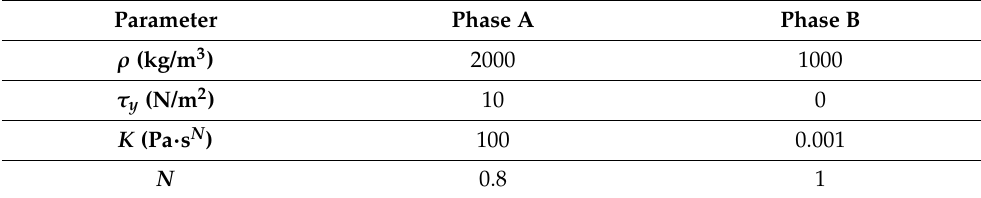
Table 1. Physical and rheological parameters used in static tank test.